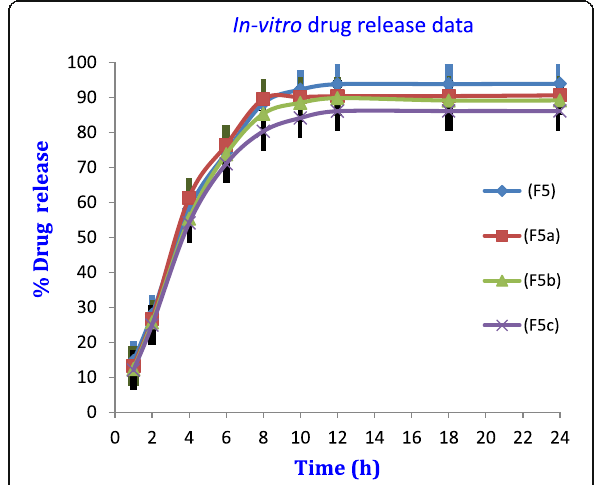
Fig. 5 In vitro drug release profile for optimized nanoemulsion (F5) and nanoemulgel formulation (F5 a , F5 b , and F5 c )